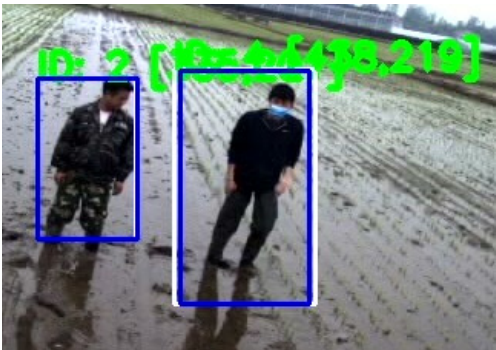
Figure 10. Detection error of the proposed method. The blue boxes are bounding boxes, the white boxes are tracking boxes. IDs of Tracked farmers and center point position of each farmer are figured out by the green color.